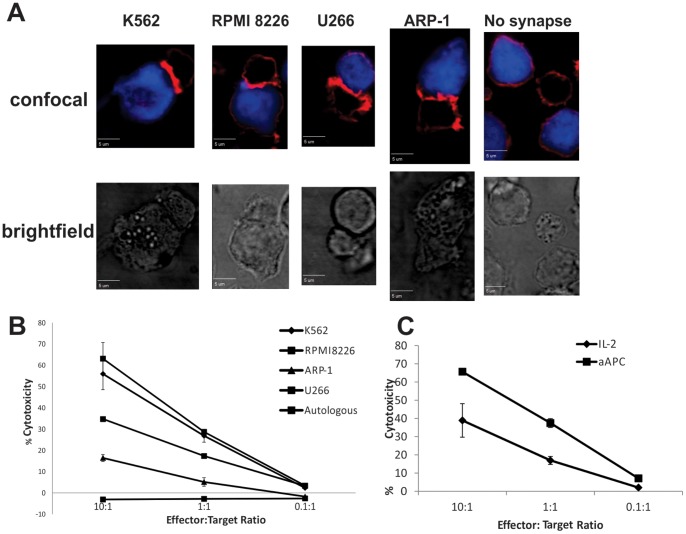
aAPC-expanded CB-NK cells form immunological synapses with and are cytotoxic against myeloma targets.A. CMAC-labeled tumor targets (blue) were incubated at a 1∶1 ratio with aAPC-expanded CB-NK cells for 15 minutes. Conjugates were then fixed, permeabilized and stained for NK effector cell F-actin with rhodamine-phalloidin (red). Confocal and brightfield images were acquired; representative images from each slide are shown. aAPC-expanded CB-NK cells form immune synapses with the classic NK target K562 as well as a variety of MM cell lines. B. aAPC-expanded CB-NK cells were co-incubated in triplicate for 4 hours with 51Cr-labeled target cells at ratios as shown. Supernatants were then harvested and analyzed the next day for 51Cr content. % Cytotoxicity = (sample value-spontaneous lysis)/(max-lysis-spontaneous lysis) x 100%. CB-NK cells demonstrate dose-dependent cytotoxicity against K562 (classic NK cell target) and MM cells lines RPMI 8266, ARP-1 and U266 (representative of n>3 assays for each cell line). C. aAPC-Expanded CB-NK cells displayed equal or more cytotoxicity against K562 cells versus CB-NK cells expanded with IL-2 alone (representative from n = 4 assays).